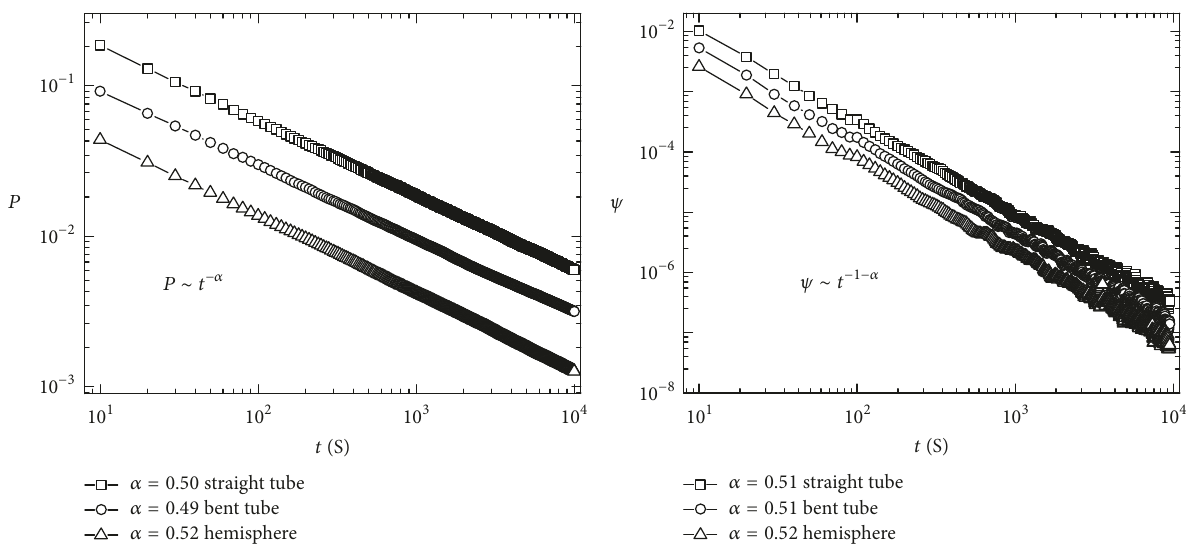
Figure 2: The power-law form of the surviving probability 𝑃(𝑡) and the waiting time distribution Ψ(𝑡) in dead-end pores at early time. The power 𝛼 approximates to 0.5 for each type of dead-end